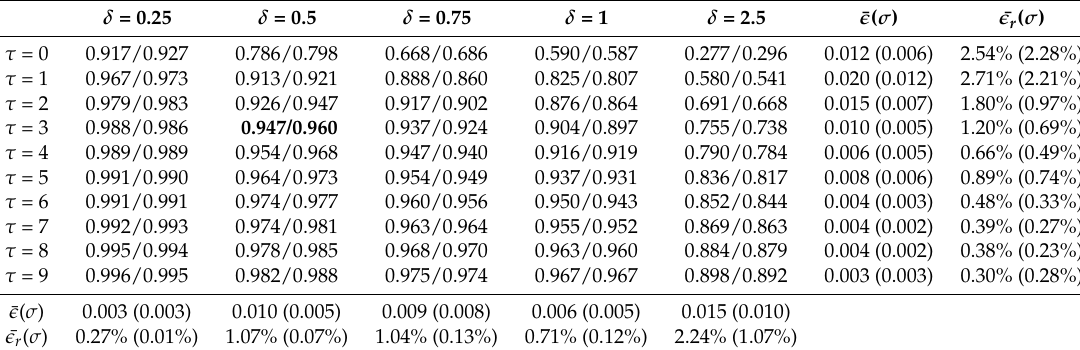
Table 4. Case study I. Transition Recall